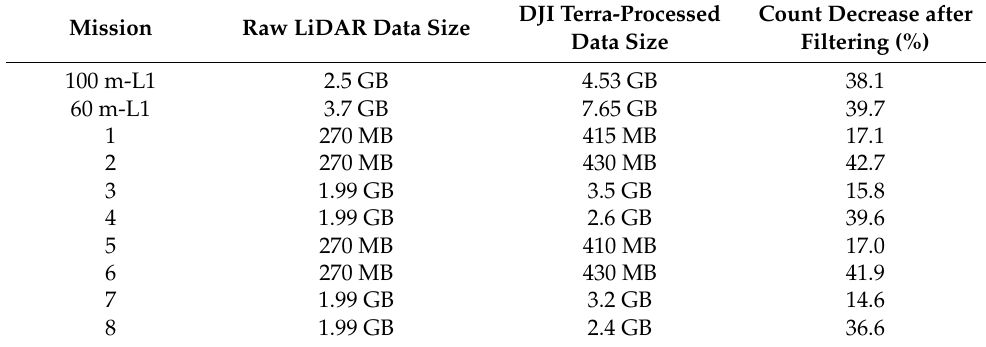
Table 5. LiDAR point cloud